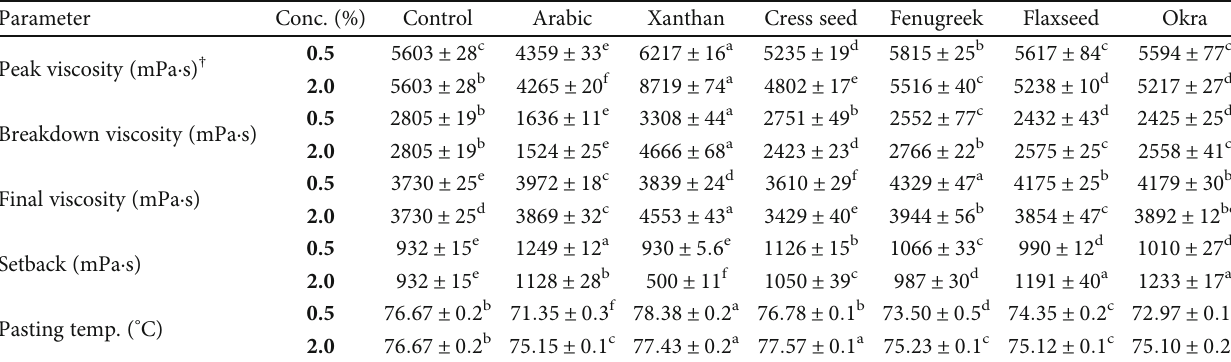
Table 1: E ff ect of gums on pasting properties of sweet potato